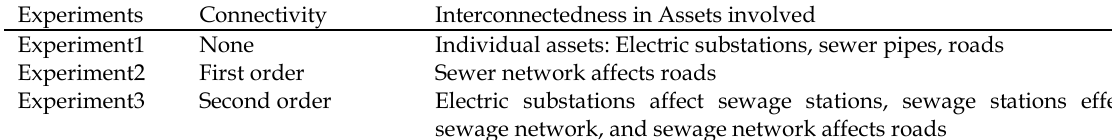
Table 3. Description of the simulation